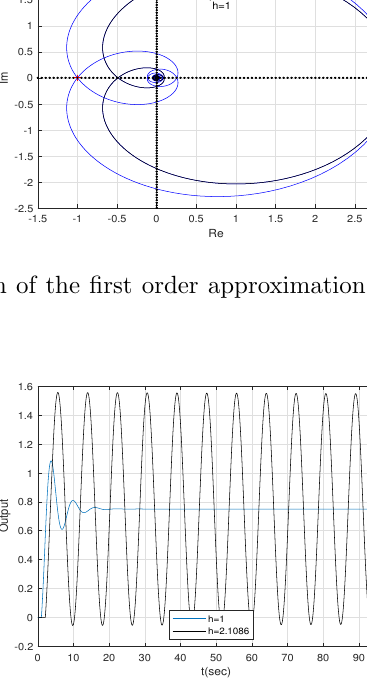
Figure 9. Unit step responses of Example 3.